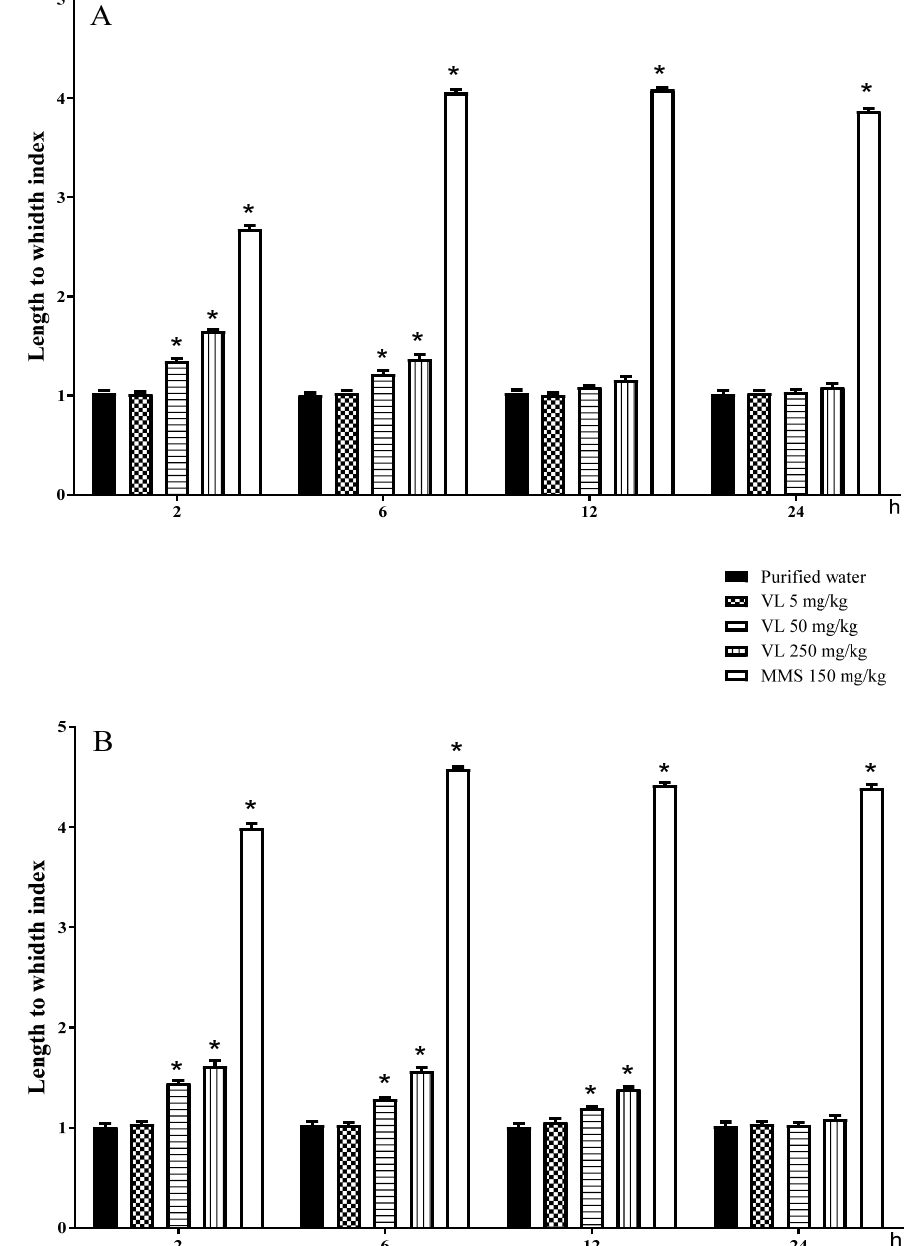
Figure 1. DNA damage induced by venlafaxine (VL) in the brain of mouse ( A ) and in mouse hepatic tissue ( B ). MMS = methyl methanesulfonate. Each bar represents the average ± SDM determined in 100 nucleoids per mouse. Five mice per dose. * Shows statistically significant difference in comparison with the control level. Two-way ANOVA and Tukey tests ( p ≤ 0.05).